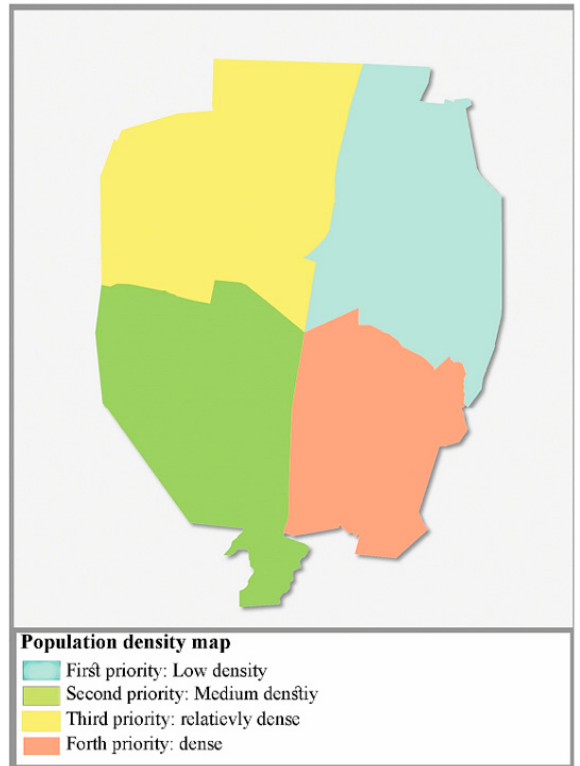
Figure 15. The population density map of Hamedan based on the sub-criteria measures in Table 1.